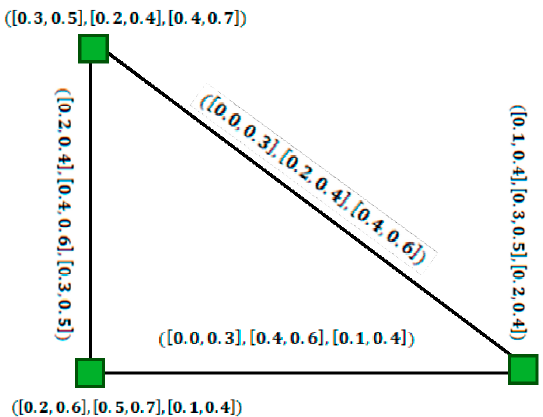
Figure 23. Interval-valued neutrosophic graph.